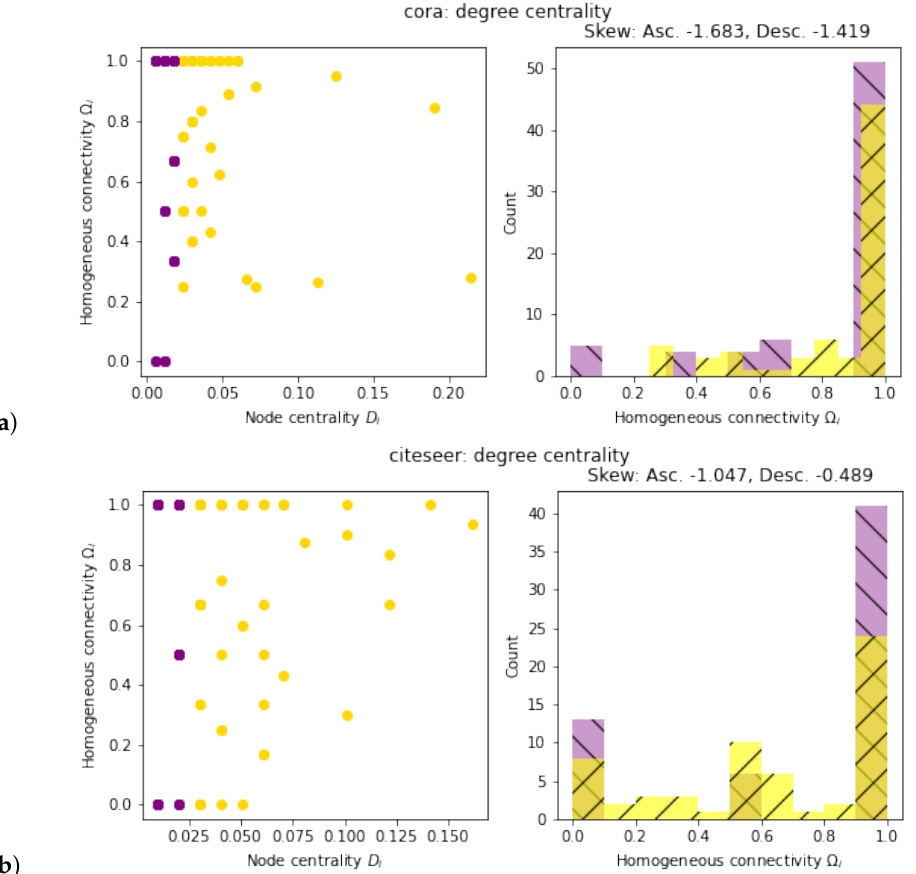
Figure 2. These plots present the investigation of datasets Cora ( a ) and Citeseer ( b ) to see the association of the centrality and the within or between edge class category edges contained. The left panels here present scatter plots of node degree centrality, D i against node homogeneous connectivity Ω i on the training data. The upper half of nodes according to their centrality are colored in yellow while the lower half is presented in purple. The histogram on the right visualizes the distribution of homogeneous connections. The skew for each subset’s distribution is annotated above the right